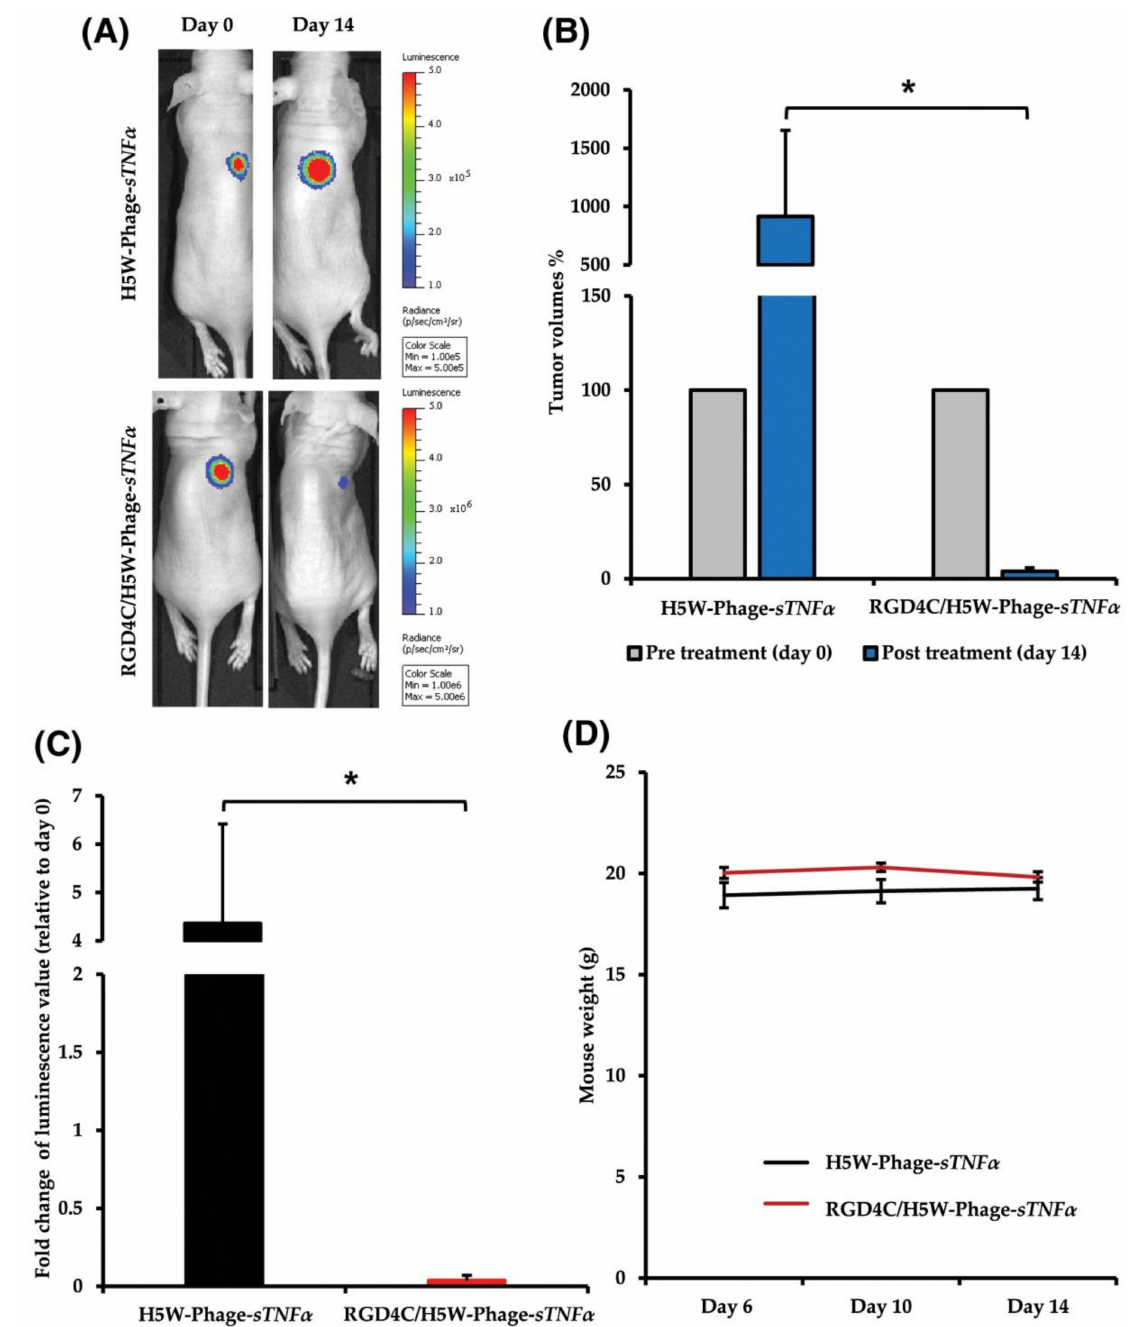
Figure 3. In vivo treatment of chondrosarcoma SW1353-bearing mice with intravenous adminis- trations of RGD4C/H5W-Phage-sTNF α . Tumor-bearing mice were intravenously injected with RGD4C/H5W-Phage-sTNF α or non-targeted H5W-Phage-sTNF α vector. ( A ) Representative tumor- bearing mice imaged using the in vivo Bioluminescent Imaging System at day 0, before treatment initiation, and day 14, post-vector administration. ( B ) Average tumor volumes progression in each experimental group. ( C ) The luminescence values of tumors shown as fold change between pre- treatment day 0 and post-vector treatment day 14. ( D ) Average weights of SW1353 tumor-bearing mice. Adapted with permission from FASEB. * p <